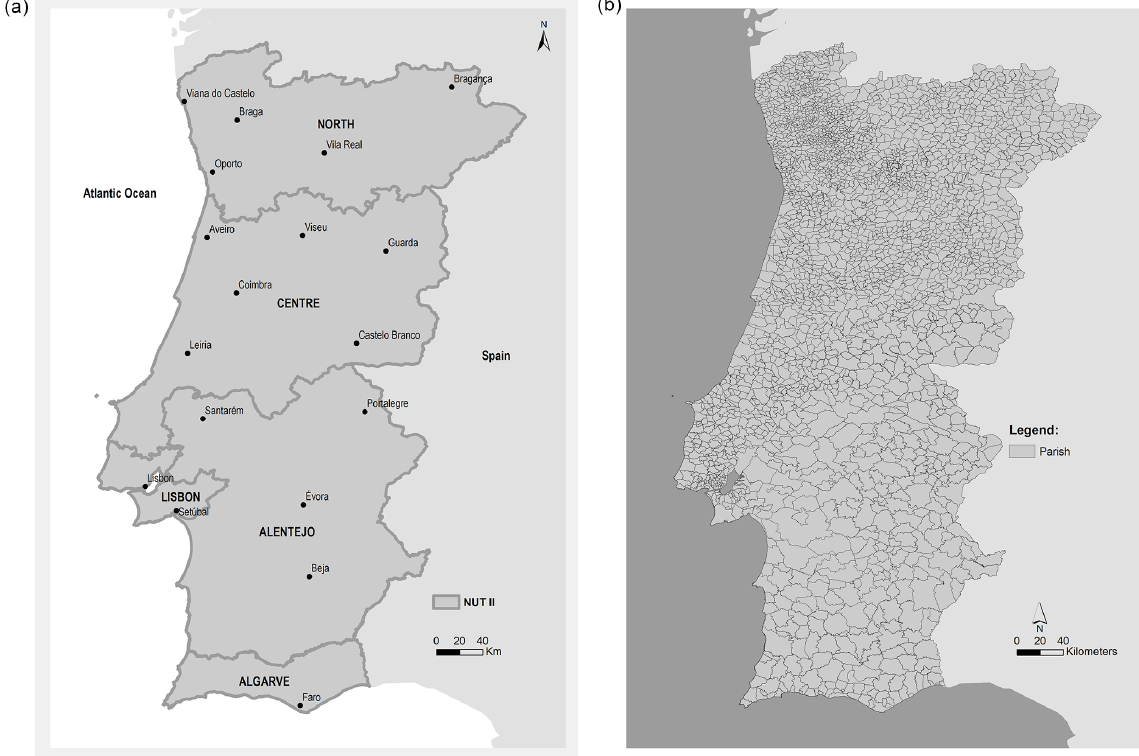
Figure 1. Characterization of the study area – (a) Portuguese NUTS II regions, main cities and municipalities and (b) Portuguese parishes.